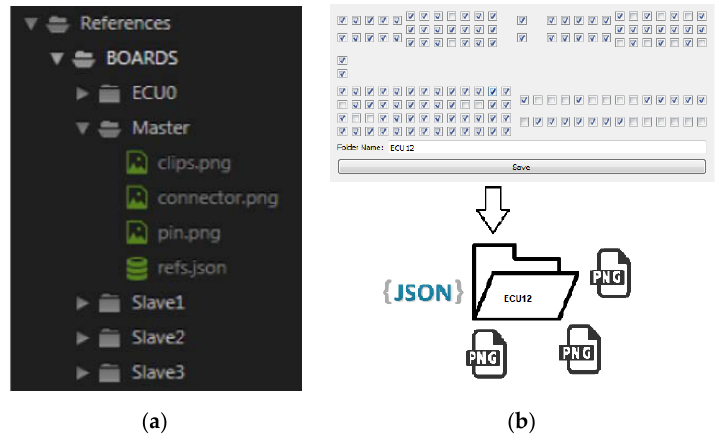
Figure 13. References ( a ) file structure; ( b ) saving procedure.